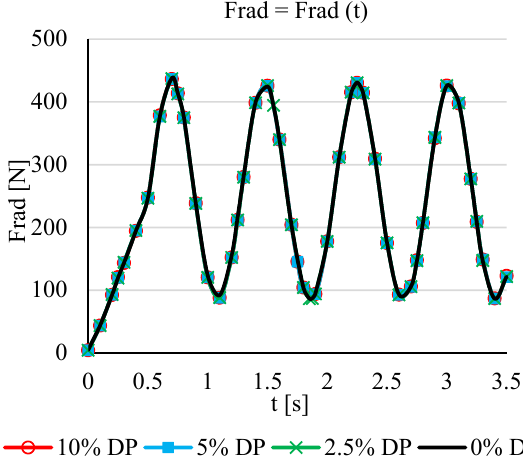
Fig. 5 Magnitude of radial forces acting on the flexible tube with different DP